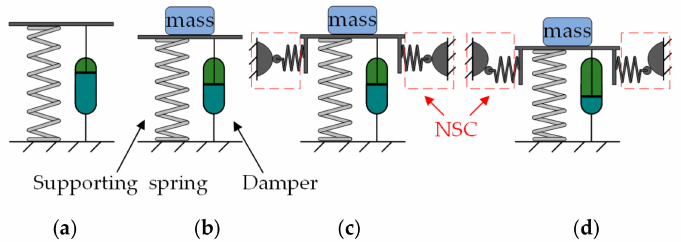
Figure 1. Negative sti ff ness corrector (NSC) in a nonlinear vibration isolator. ( a ) Unloaded linear spring; ( b ) loaded linear spring at static equilibrium position; ( c ) isolator with NSC at static equilibrium position; ( d ) isolator with NSC in operation.